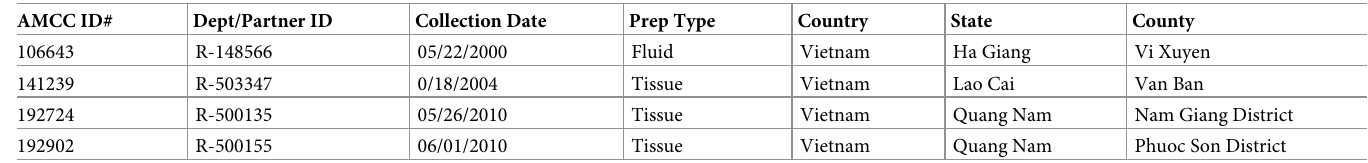
Table 1. Metadata on four wild Asian water dragon samples obtained from collections at the American Museum of Natural